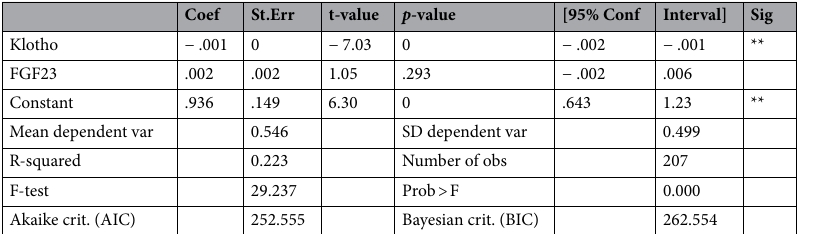
Coef St.Err t-value p -value [95% Conf Interval] Sig